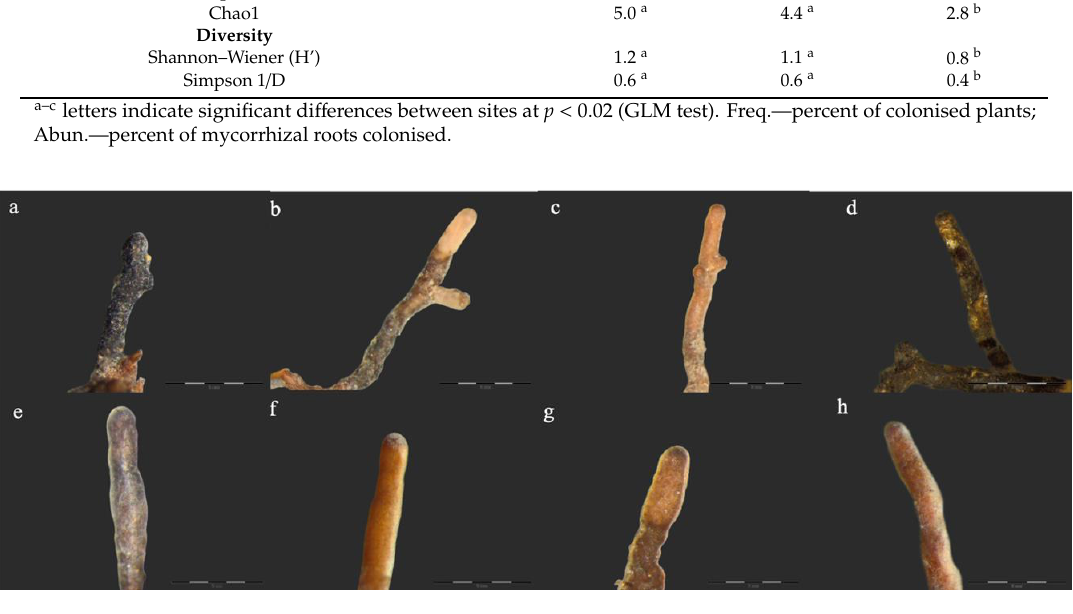
Table 2. Estimated species richness, diversity, and occurrence of ectomycorrhizal fungal taxa associated with the roots of Crimean linden.